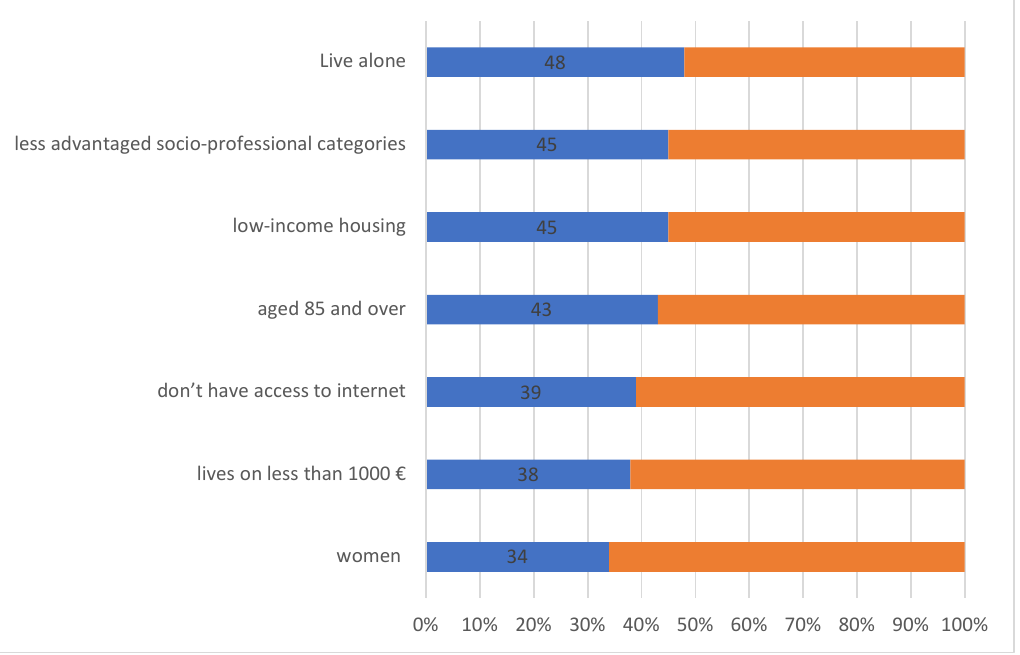
Figure 2. Profile of people aged 60 and over who feel lonely [35].